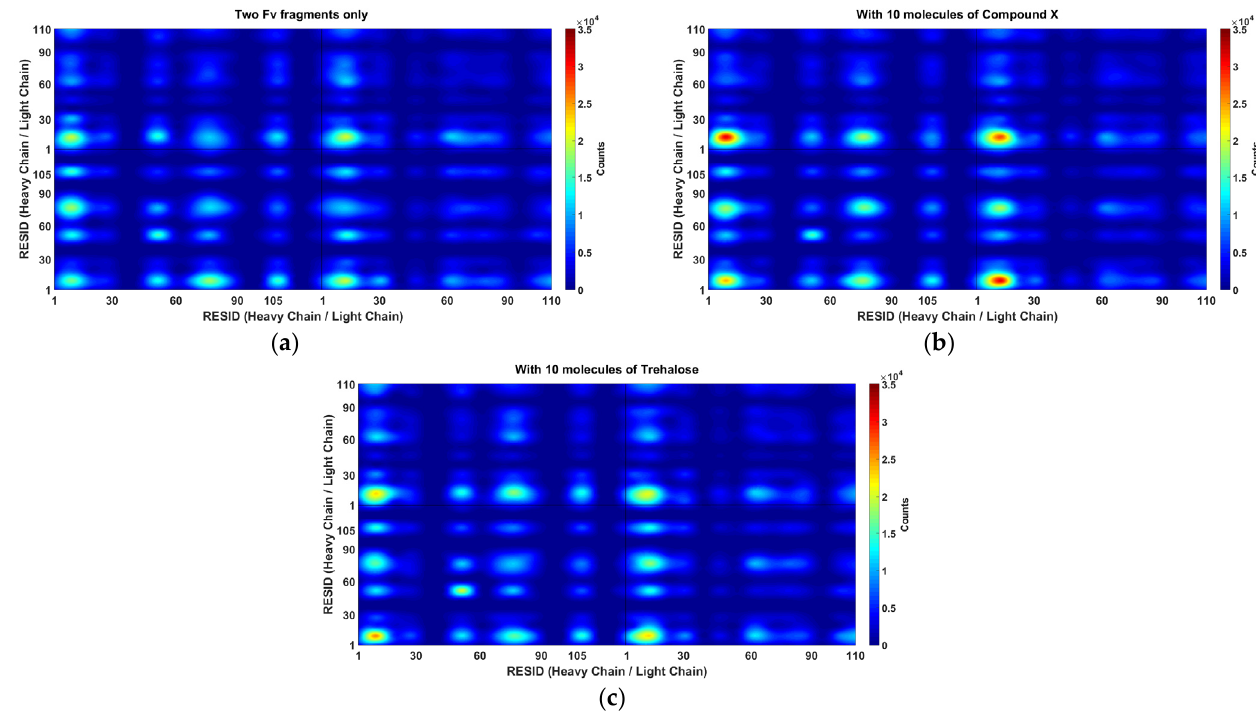
Figure 6. Common binding pairs in a set of 1024 MARTINI CG simulations ( a ) with just two mAb1 Fv fragments in 100 mM NaCl, ( b ) with 10 molecules of Compound X and ( c ) with 10 molecules of Trehalose. The occurrence of interaction pairs were coloured according to the colour bar on the right. Main self-association events occur in the CDR1 near residue GLU16 on the light chain. Apart from LEU105, alternative interaction hot-spots were also identified, including LYS13, PHE55 and SER75 on the heavy chain. The occurrences of interaction events the most solvent-accessible hydrophobic patch (LEU105 on heavy chain) slightly reduces with the addition of Compound X . Please note that MARTINI representation was based on four-to-one mapping and this graph was generated based on interactions between individual beads not by residue so the number of interaction events may appear differently to Figure 8.